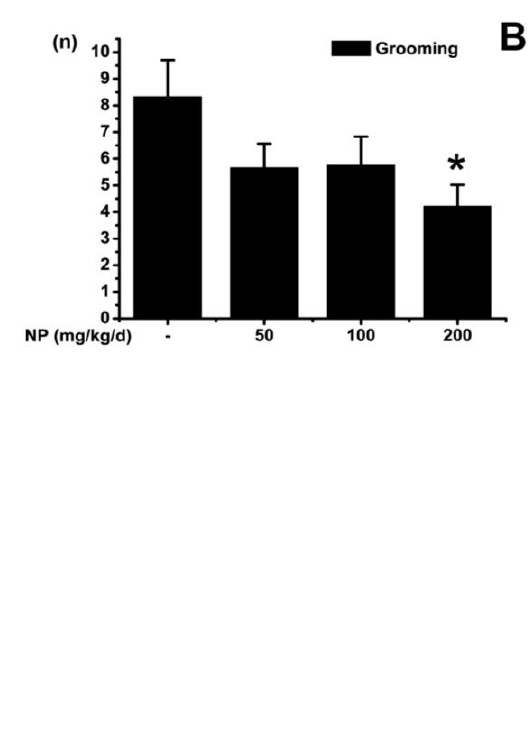
Figure 1. The locomotor and exploratory behavior of nonylphenol (NP) treated mice at different doses or vehicle ( n = 9). All values are expressed as means ± S.E.M. ( A ) Comparison of crossing numbers (within 5 min); ( B ) Comparison of rearing/leaning numbers (within 5 min); ( C ) Comparison of grooming numbers (within 5 min). * p < 0.05 vs. the vehicle